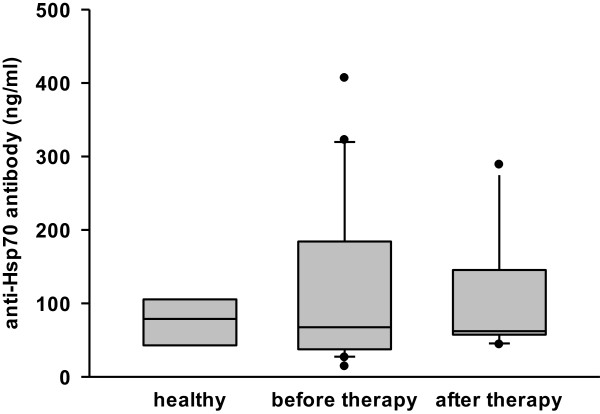
Anti-Hsp70 antibody levels in the serum of patients before, and at indicated time-points after radiation therapy.Time course of anti-Hsp70 antibodies in the serum of patients with SCCHN tumors before and after therapy. Blood was collected and anti-Hsp70 antibodies were determined by anti-Hsp70 antibody ELISA. Standard box plots are shown with boundaries indicating the 25th and the 75th percentile. The line inside boxes indicates the median and the whiskers indicate the 10th and 90th percentile, respectively. All outliers are shown in the graph. (healthy n = 4, patients before therapy n = 16, patients after therapy at least 6 weeks after radiation therapy n = 6).